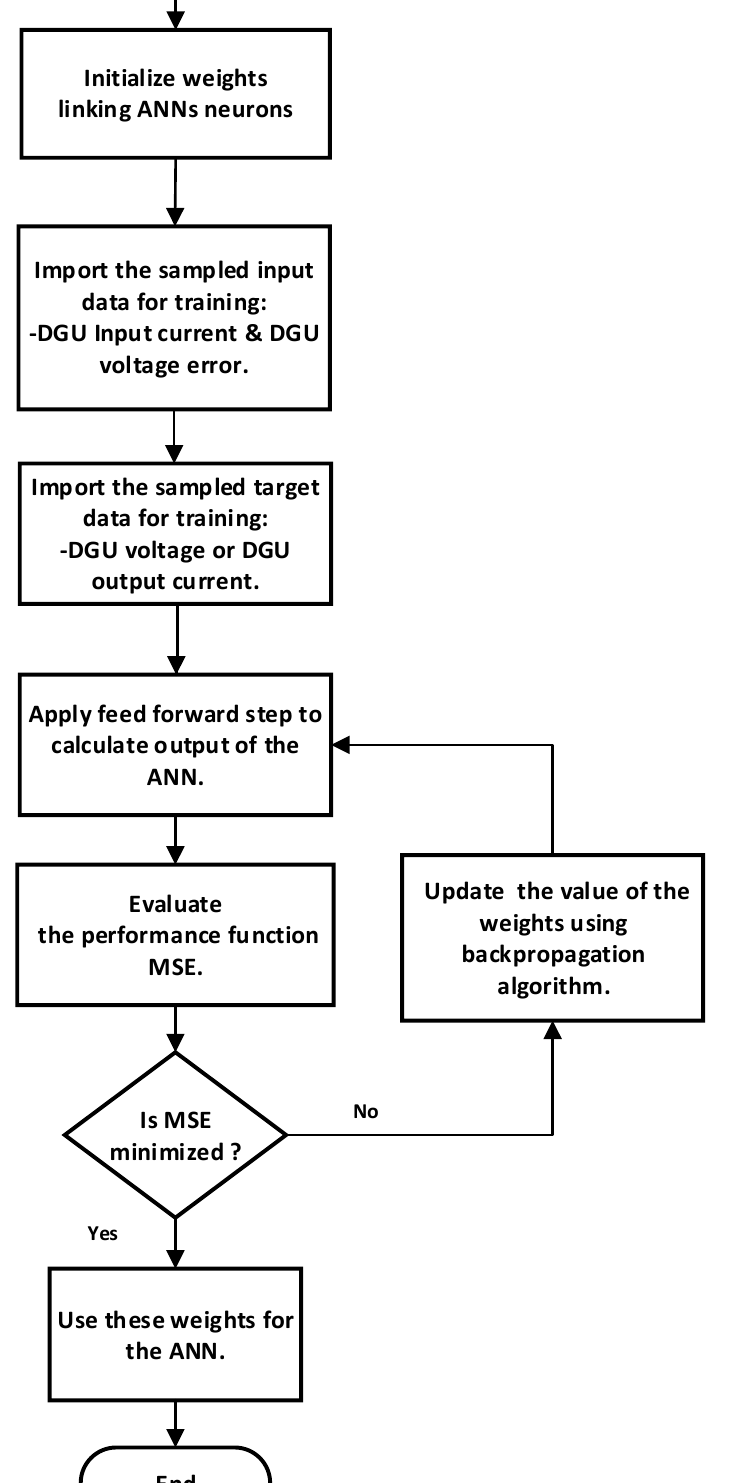
Figure 8. Flowchart for voltage and current cyber-attack ANNs training.